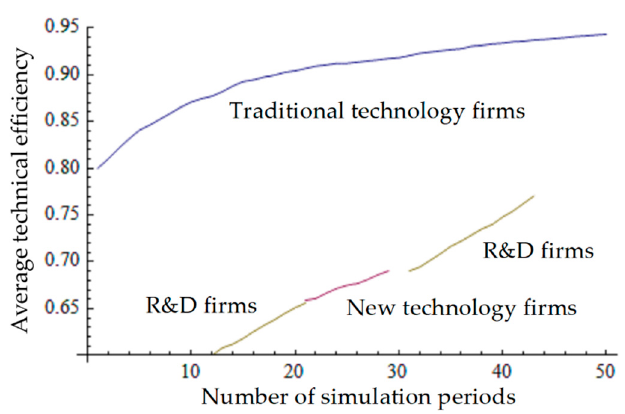
Figure 5. Production change in the biodiesel industry.